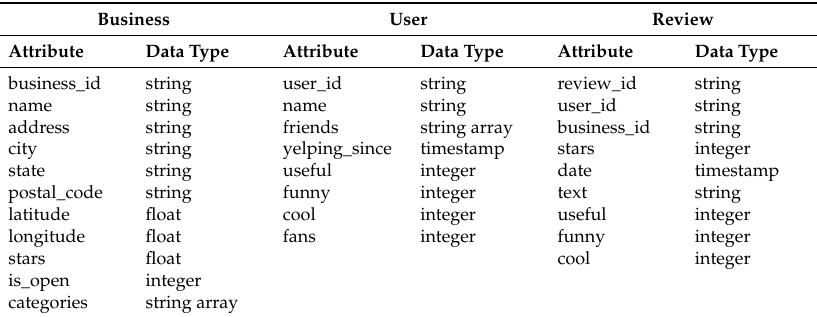
Table 2. Data used from the Yelp dataset after preprocessing.